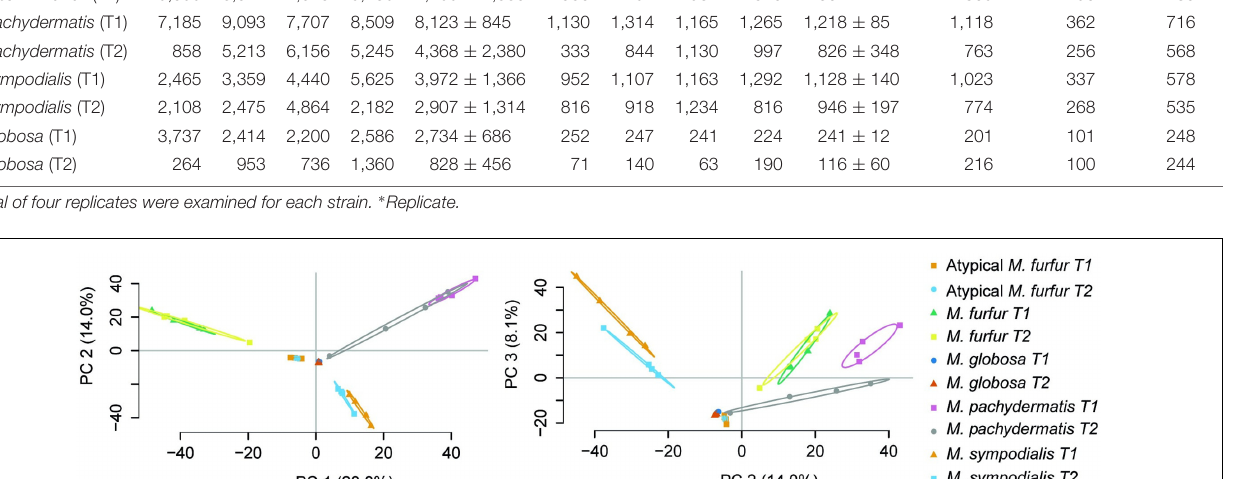
proteins Enzymes Reactions